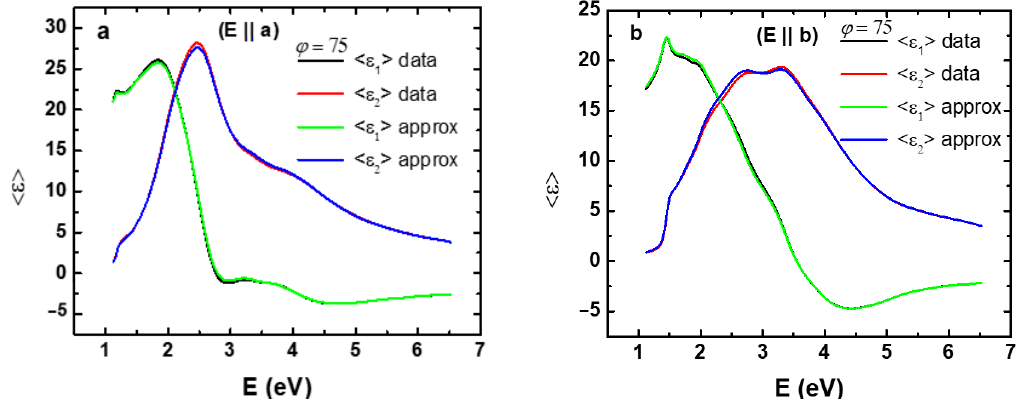
Figure 4. The pseudodielectric function of SnS 0.52 Se 0.48 along zigzag direction ( a ) and armchair direction ( b ) measured at AOI = 75° (black and red) and the resulting data (green and blue) after approximation method was applied.